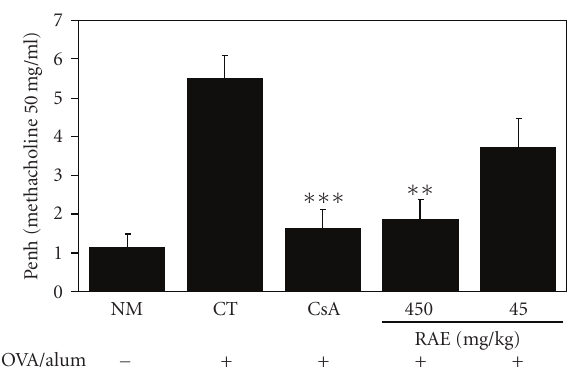
Figure 1: E ff ects of RAE and CsA on methacholine-induced AHR in the sensitization (NM: normal C57BL/6 mice; CT: OVA-induced asthma mice (control); CsA: OVA-induced asthma mice treated with cyclosporine A (10mg/kg); RAE 450 mg/kg: OVA-induced asthma mice treated with RAE (450 mg/kg); RAE 45mg/kg: OVA- induced asthma mice treated with RAE